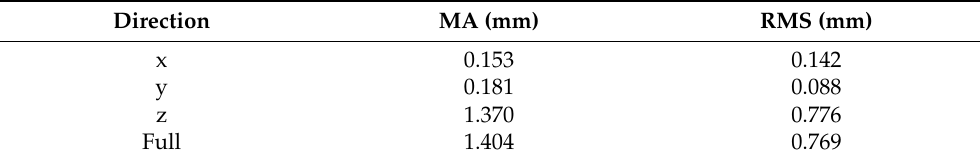
Figure 16. The points on the 3D structure reconstructed by the VMOS by TriTop ® .